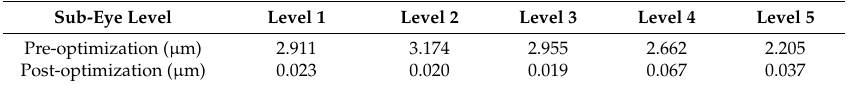
Table 3. Ball differences for each level before and after sub-eye lens optimization.